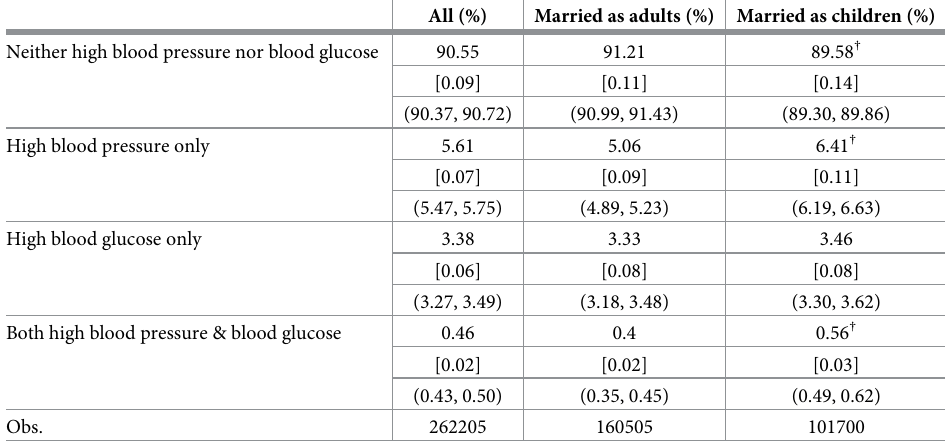
Obs. 101700 Estimates were obtained using complex survey weights. Linearized standard errors are in square brackets. 95% confidence intervals are in parenthesis. †